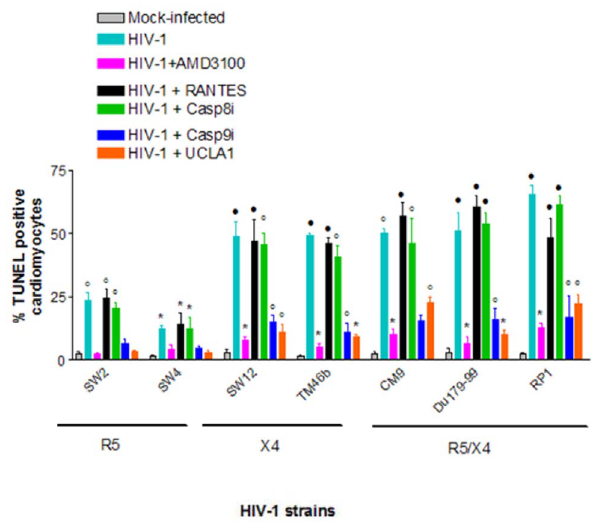
Figure 3. Quantification of the relationship between HIV-1 tropism and induction of CM apoptosis using TUNEL assay. Statistically significant TUNEL positive results compared to mock- infected control cells were determined by the student t -test and are marked as: *, P , 0.05; ? , P , 0.005; u , P , 0.0005 (n=3 6 SEM).